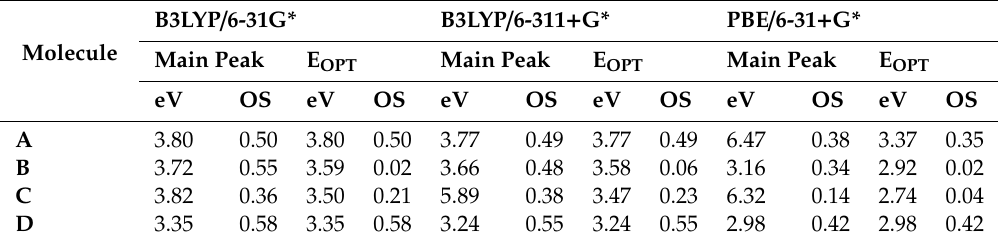
Table 4. Energy and oscillator strength (OS) for the main peak (MP) and optical onset (E OPT ) extracted from the absorption spectra.